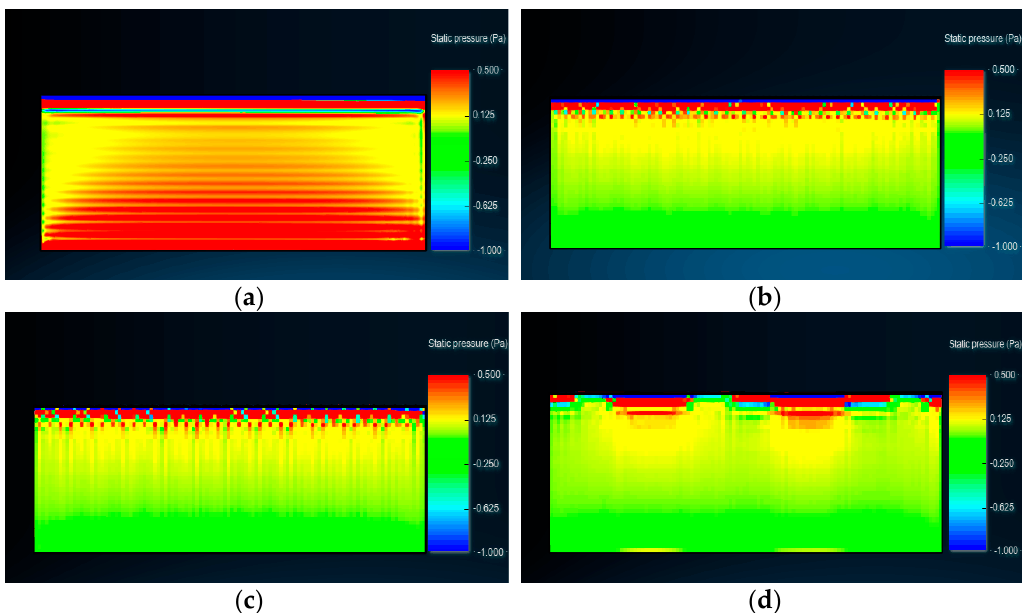
Figure 8. 1/3 octave sound pressure level curves of different bionic wings.